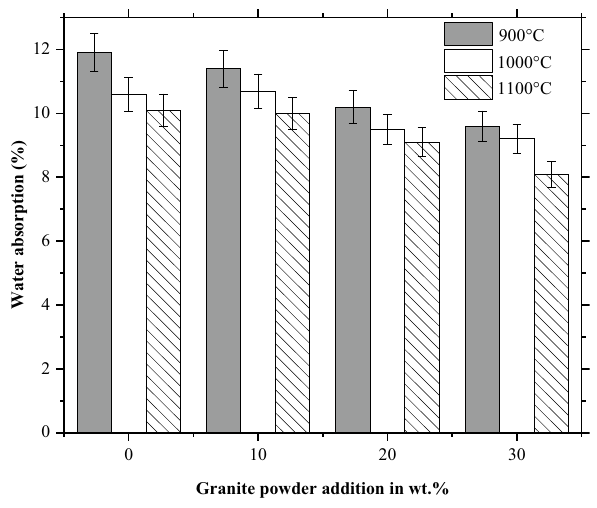
Fig. 4 Water absorption of the FCBS fired at 900–1100 °C